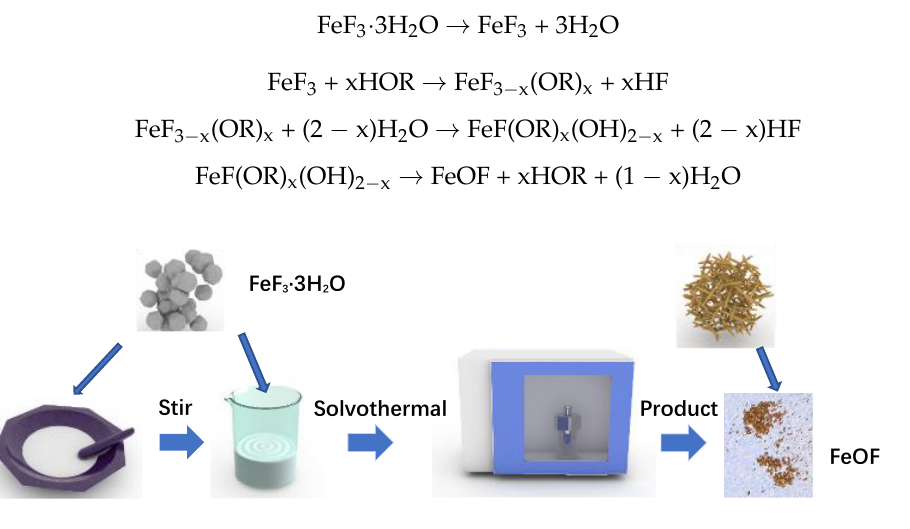
Figure 1. Schematic process of the formation of FeOF nanorods. The XRD patterns of the precursor FeF 3 · 3H 2 O and the synthesized FeOF are shown in Figure 2. All the observed reflections of the synthesized sample can be indexed to that of FeOF (JCDS card No. 70-1522) with a tetragonal rutile structure. The precursor FeF 3 · 3H 2 O is also composed of the pure FeF 3 · 3H 2 O phase. Both the precursor and the obtained sample are crystallized well, as seen from the XRD results. The crystal size of both the reactant and the product are listed in Table 1. For each material, the crystal size changes slightly with the facet index. However, the grain size of FeF 3 · 3H 2 O material is obviously larger.